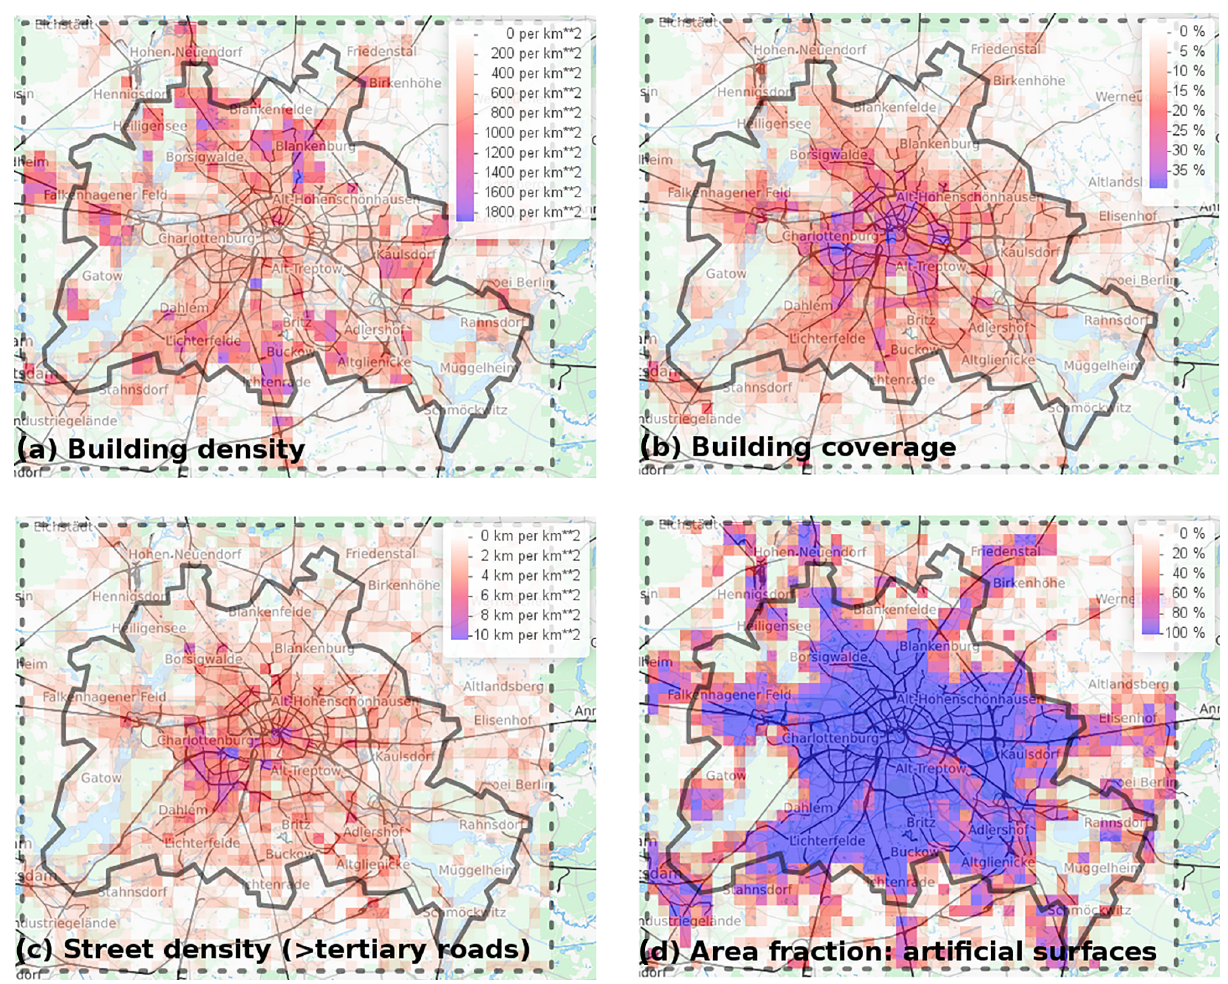
Figure 3. Example set of exposure predictors calculated on a 1 × 1km grid. While building density (a) , building coverage (b) and street density for tertiary roads and higher (c) are based on information extracted from OpenStreetMap data, panel (d) shows the area fraction of artificial surfaces as derived from the CORINE land cover data